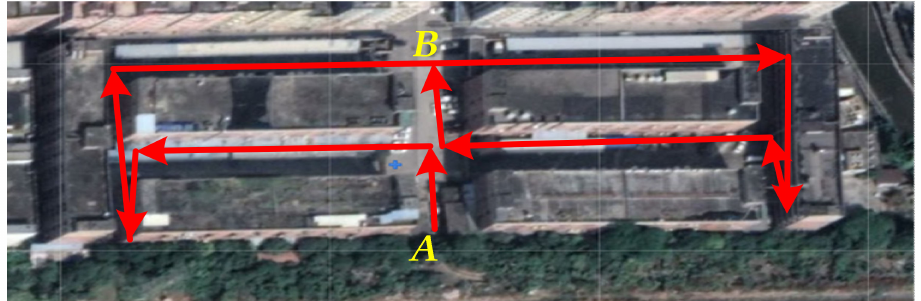
Figure 5. The experimental subject was a neighborhood. The red line is the path of movement when we measured the data. The A was the starting point from which we started the measurement, and the B was the endpoint.